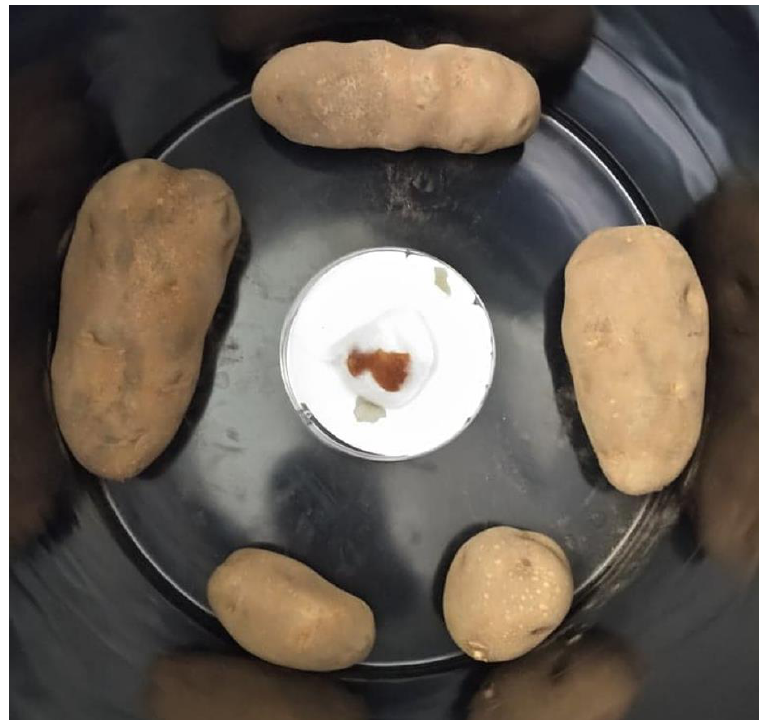
Figure 3. The experimental setup with tubers placed around a Petri dish lined with filter paper containing a cotton ball onto which essential oil was placed.